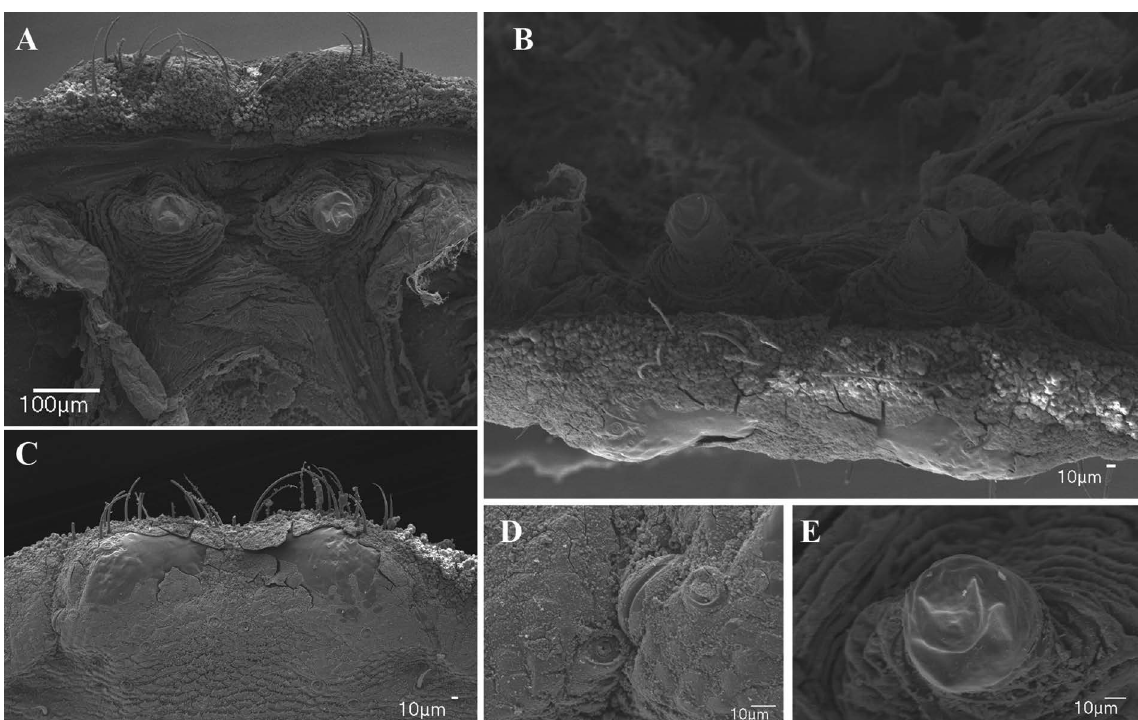
Fig. 138. Sarax bispinosus (Nair, 1934) (AMNH), female gonopod and genital operculum. A . Finger- like gonopod, dorsal view. B . Gonopods, posterior view. C . Posterior margin of genital operculum, ventral view. D . Glandular opening on margin of genital operculum. E . Dextral